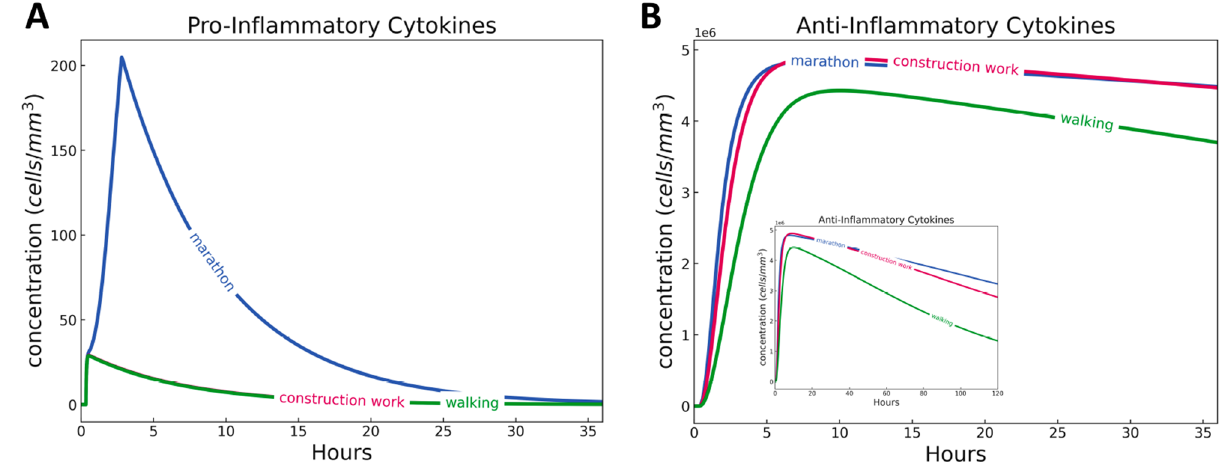
Figure 6. Dynamics of pro- and anti-inflammatory cytokines during and after three physical activities simulated for 36 h/1.5 days (main) and 120 h/5 days (snippet). Marathon (2 h and 46 min) induced more pro-inflammatory cytokines than construction work (9 h with a 1 h break in between) and walking (6 h), while all three physical activities induced similar concentrations of anti-inflammatory cytokines. Marathon’s anti- inflammatory cytokines decline after 10 h, signifying the depletion of immune cells that produce